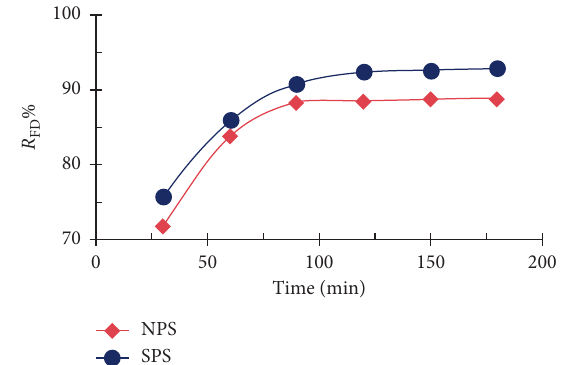
Figure 6: Contact time effect on NPS and SPS quantities of FD removal (1g adsorbent dosage; 10mg/L FD concentration; 50ml solution volume; and 25 ° C